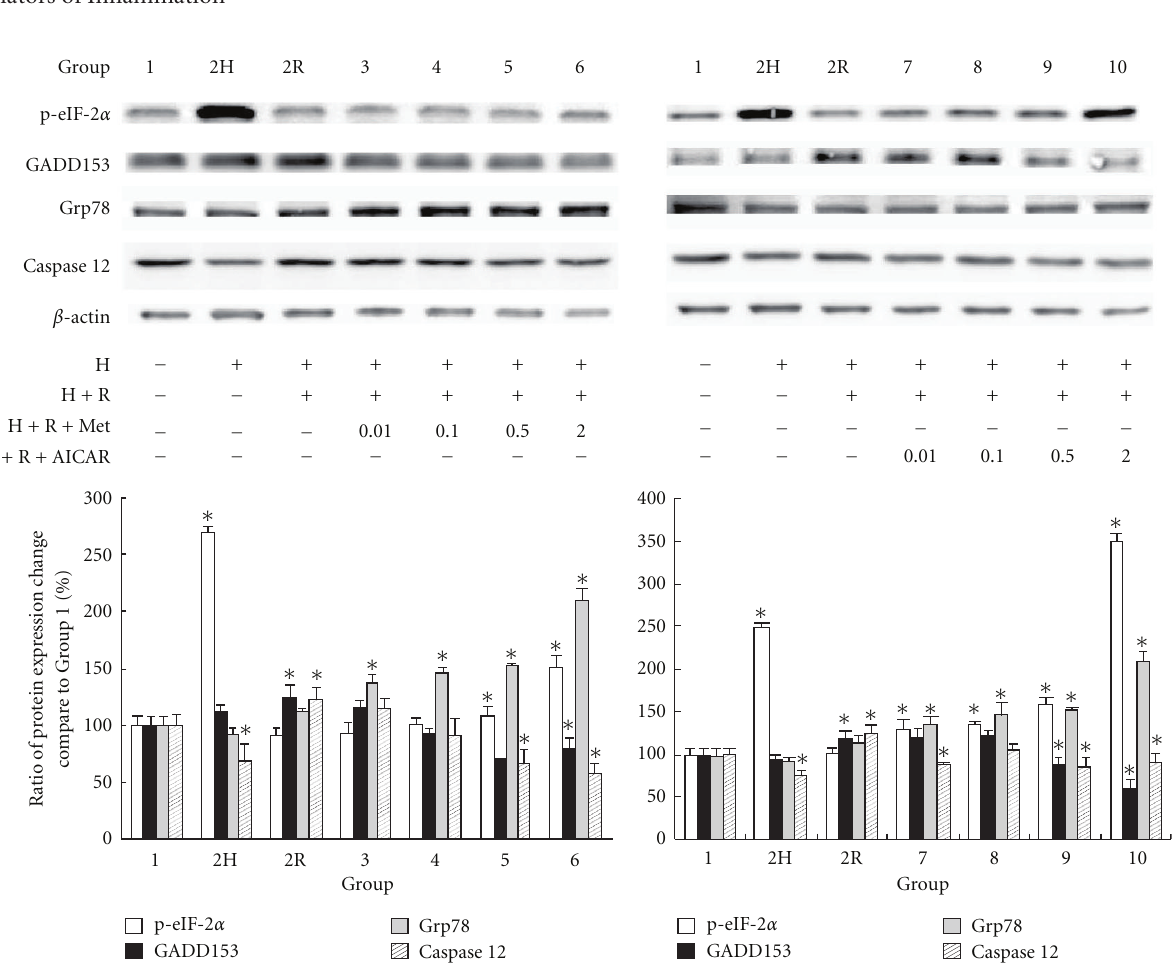
Figure 2: The results of western blot analysis of phosphorylated eIF-2 α , GADD153, Grp78, and caspase-12 (B) in di ff erent groups are shown. β -actin was used as internal control. (Results are representative of at least 3 separate experiments. ∗ P < . 05 compared with Group 1; H: hypoxia; R: reoxygenation; Met: